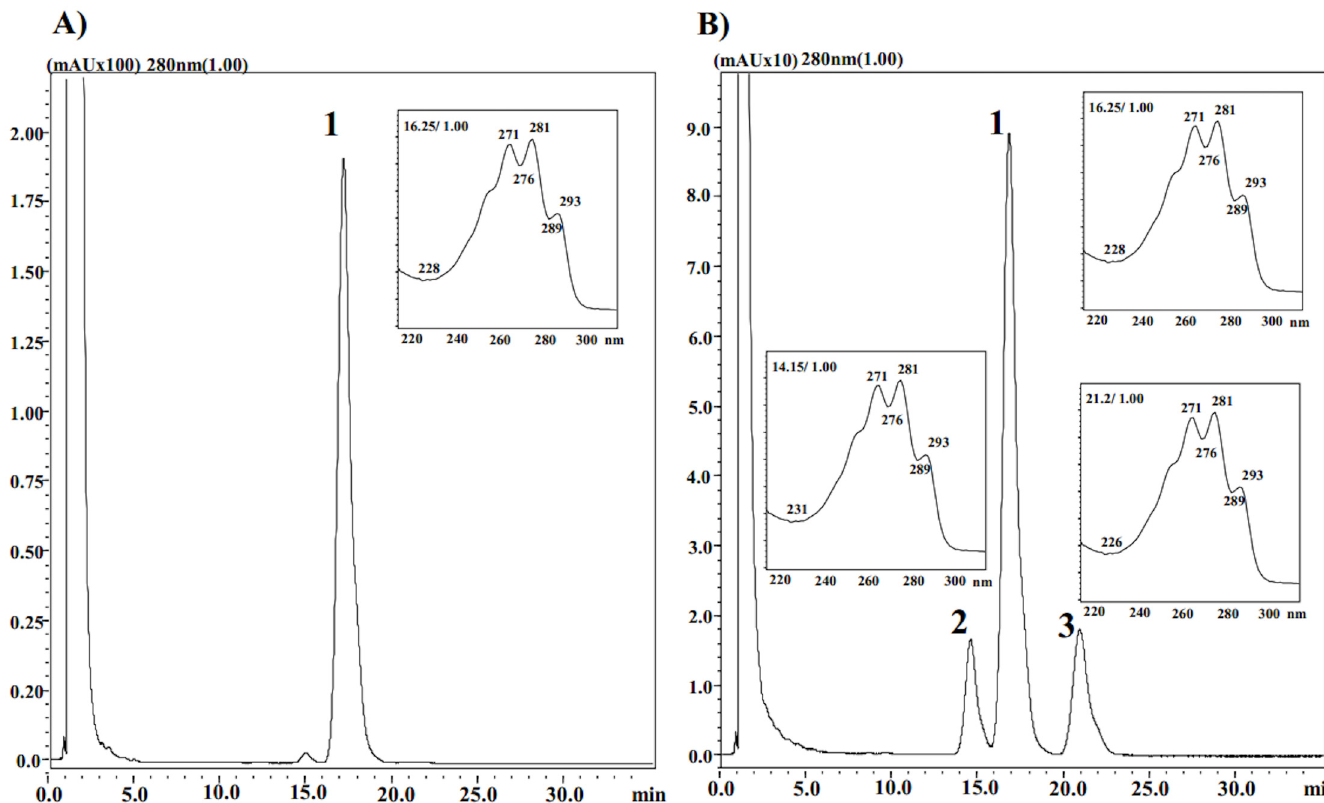
Fig 1. RP-HPLC analysis of sterols from the wild-type and crtR - mutant strain. Chromatograms (at 280 nm) correspond to sterols extracted after 72 h of culture from the (A) wild-type (CBS 6938) and (B) CBSTr strain ( crtR - ). The corresponding spectra were displayed beside each peak (peaks N° 1 to 3). Peak 1 corresponds to ergosterol, which was confirmed by co-injecting the sample with standard